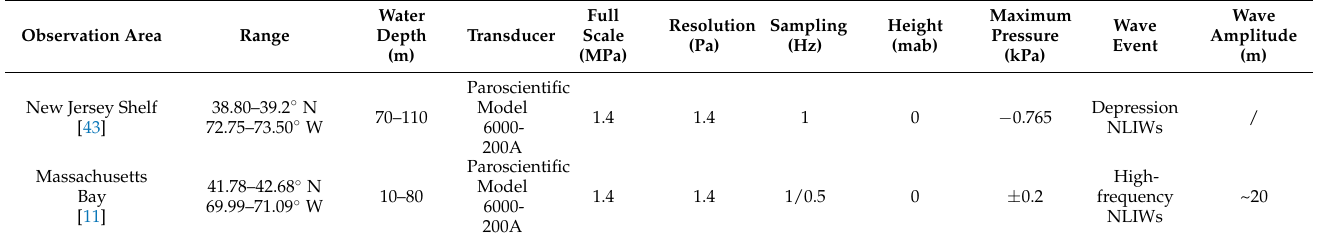
Table 1. Summary of past 15 years on the observation details of seafloor pressure disturbance induced by internal